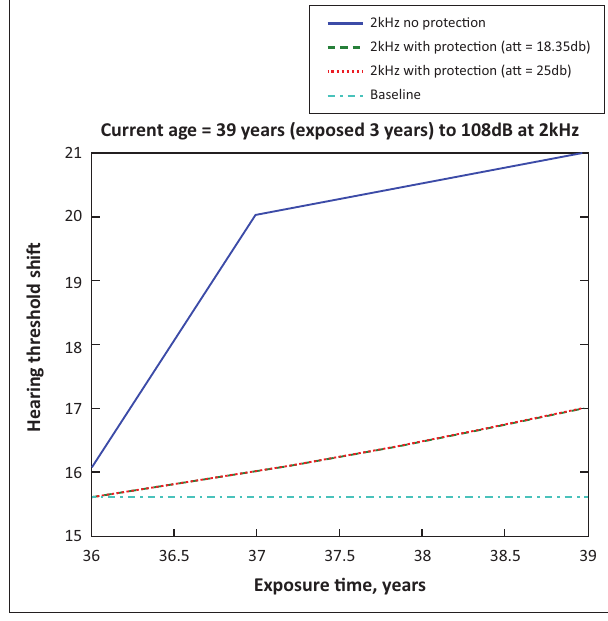
Source : Figure created using data from Moroe, N.F. (2018). Occupational noise-induced hearing loss in South African large scale mines: From policy formulation to implementation and monitoring . Doctoral thesis. Johannesburg: University of the Witwatersrand. FIGURE 6: Thirty-nine years old at 2000 Hz with exposure levels of 108 dB.